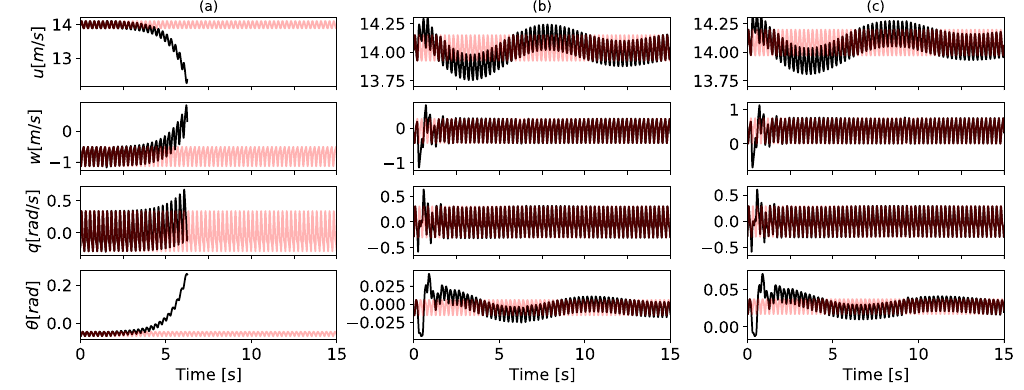
Figure 5. Dynamic response of the three representatives limit cycles, to a Gaussian-like upward gust. Case ( a ) Separation of the perturbed solution along the unstable eigendirection (black) from the periodic orbit. Case ( b ) and ( c ) Passively stable response. After a transient, the perturbed trajectory (black) tends to converge back to the level steady flight condition (red) (Color figure online).